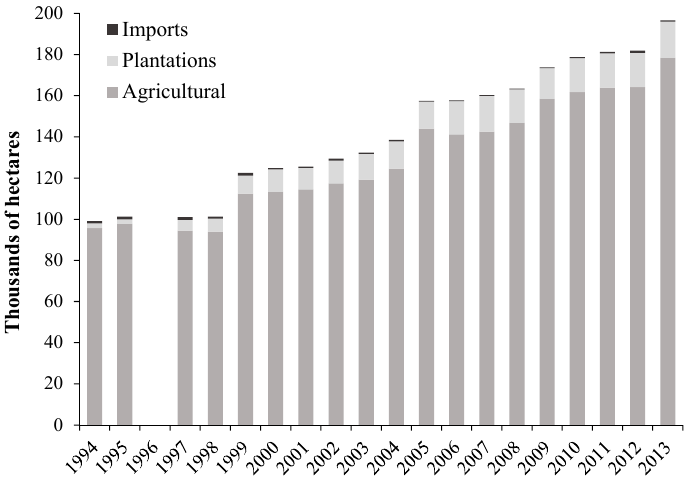
Figure 6. Evolution of the land demand associated with the cultivation and export of bananas, pineapples, palm oil, melons, and cassava in Costa Rica over 1994–2013, highlighting the contribution of three components. The agricultural and plantations components refer respectively to cropland expansion and the increasing area of plantations that has been required to produce the wood pallets used for crops exports in Costa Rica. The imports component corresponds to the area of forest plantations that was required abroad to produce the pallets imported by Costa Rica. The land demand associated with the unexplained supply over the period 1994-2001 has been